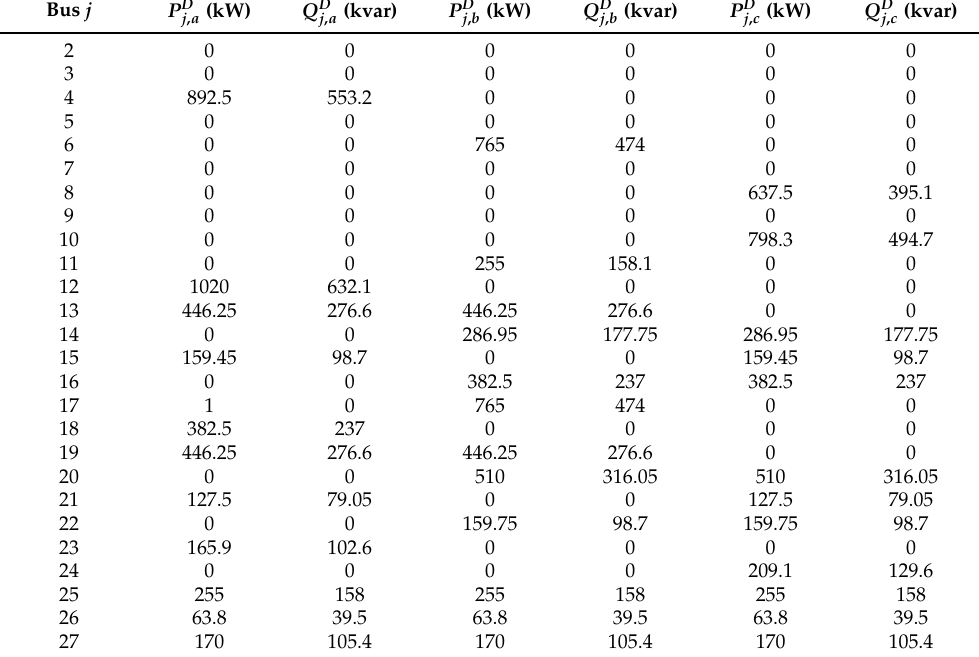
The data for the unbalanced case of the 27-bus system are presented in Table 8, where the levels of both active and reactive load present in each bus are indicated. Table 8. Load for each phase in the 27-bus test system for the unbalanced